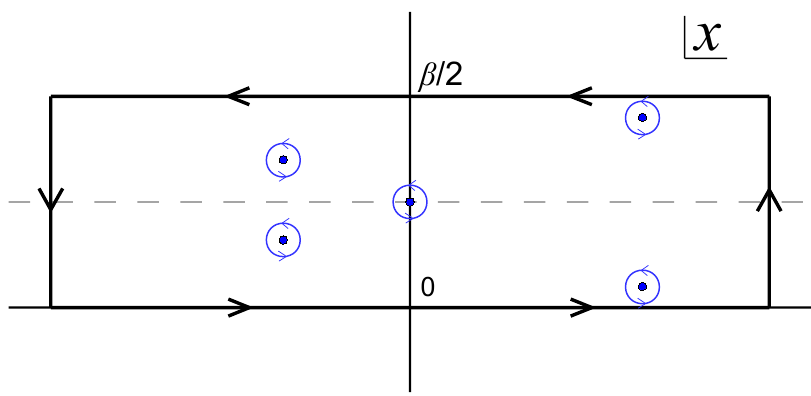
Figure 3 . The contour used to calculate the re(cid:13)ection coe(cid:14)cient in the Born approximation. It goes counter clockwise around the strip j Re x j (cid:20) 1 ; 0 (cid:20) Im x (cid:20) (cid:12)= 2. Blue dots represent possible locations of poles of V ( x ). The large contour (black) is equivalent to the sum of the small contours (blue) encircling the